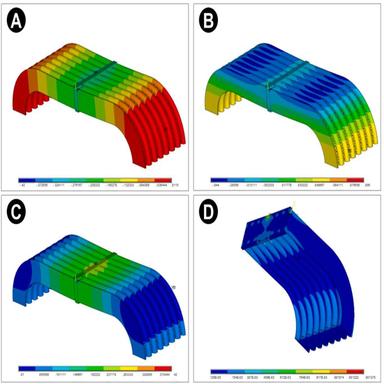
Maps obtained for the force applied on the upper surface: (A) displacement in Y direction , (B) displacement in Z direction (C) axial displacement and (D) reduced stresses.